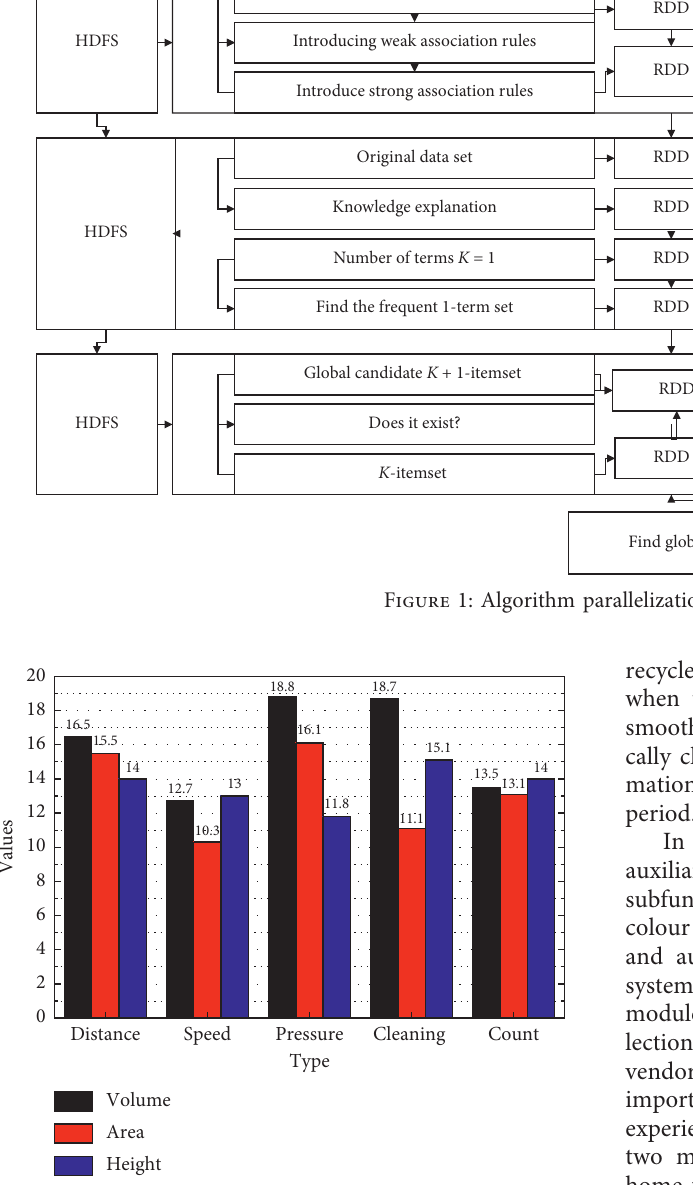
Figure 2: Parameter recommendation